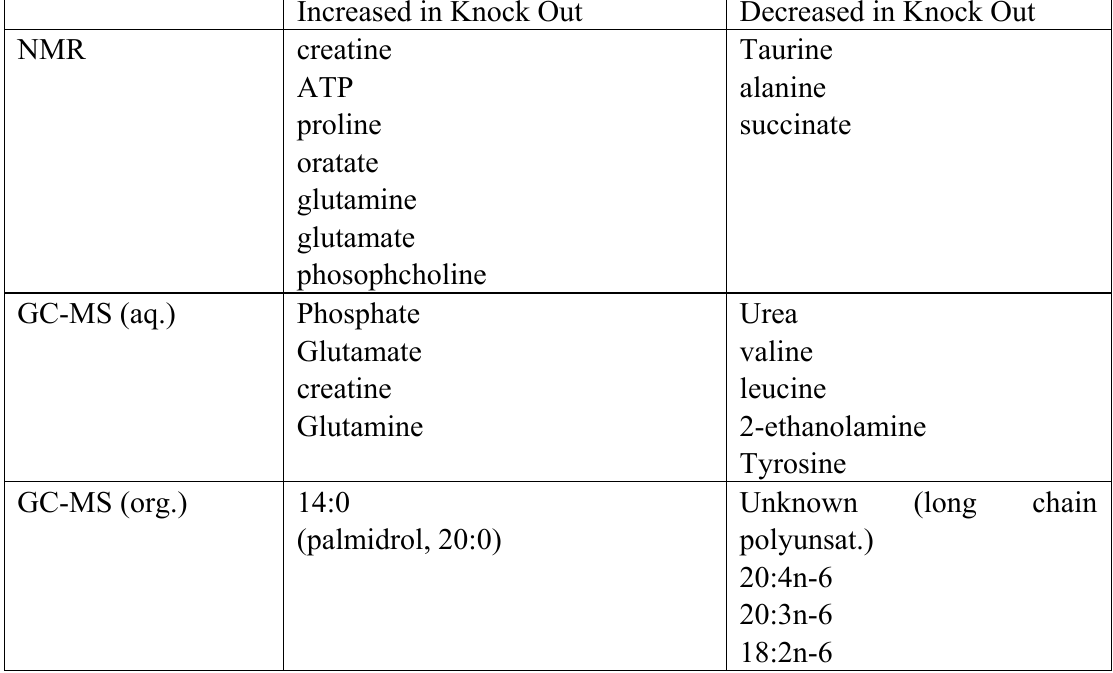
Table 3. Changes in the concentration of metabolites detected by NMR spectroscopy and GC-MS using the combined male and female dataset. Similar changes were detected in the individual gender